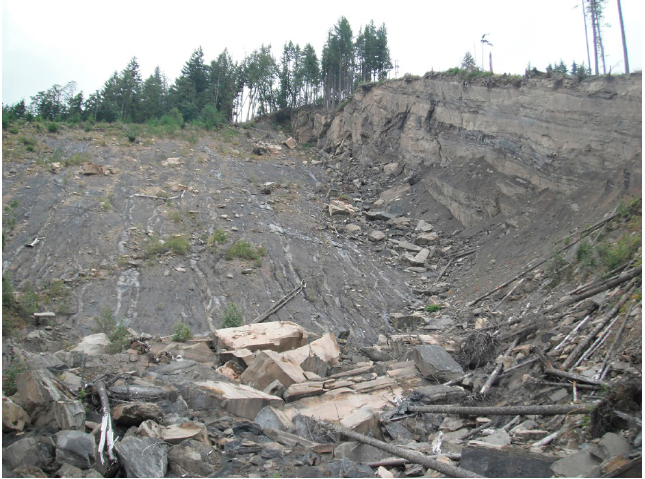
Figure 3. Racehorse Creek landslide, locality WWU-RCS-1.